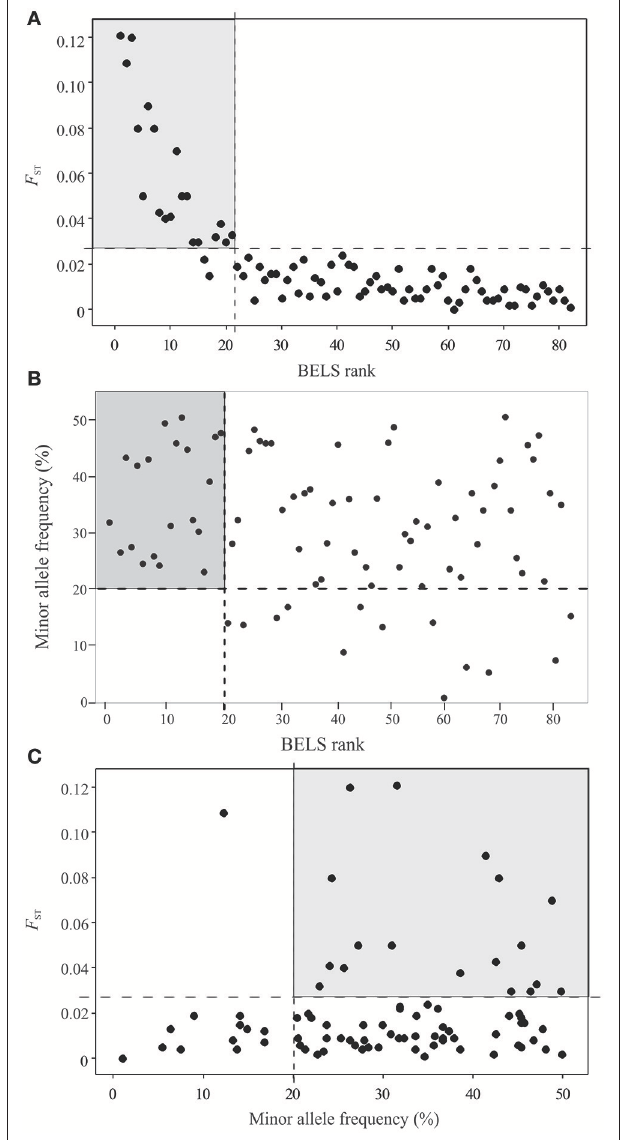
FIGURE 2 | Loci assessment and selection of high performance SNPs based on BELS ranking, F ST value and minor allele frequency (MAF). (A) Scatter plot of BELS ranking (X-axis) against F ST value (Y-axis). SNP loci are indicated as close circles. The gray-shaded area contains SNP loci that are ranked as the top 20 based on BELS performance score and have F ST ≥ 0.03 and. (B) Scatter plot of BELS ranking (X-axis) against minor allele frequency (Y-axis). The gray-shaded area contains SNP loci that are ranked as the top 20 based on BELS performance score and MAF > 20%. (C) Scatter plot of minor allele frequency (X-axis) against F ST value (Y-axis). The gray-shaded area contains SNP loci that have F ST ≥ 0.03 and MAF > 20%.